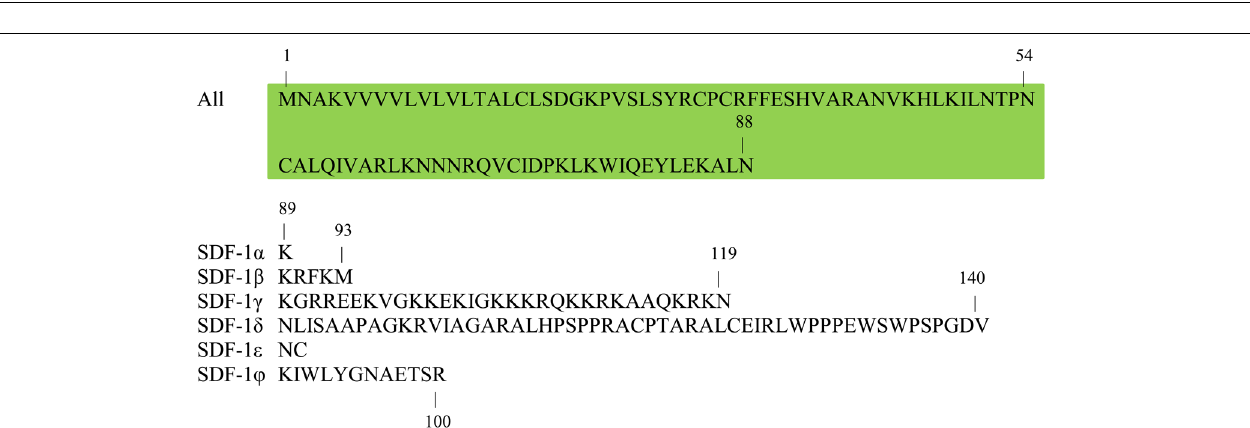
N-terminal sequence highlighted in green. Indications of specific amino acid positions inform on the length of the different CXCL12 isoforms: α (89aa),